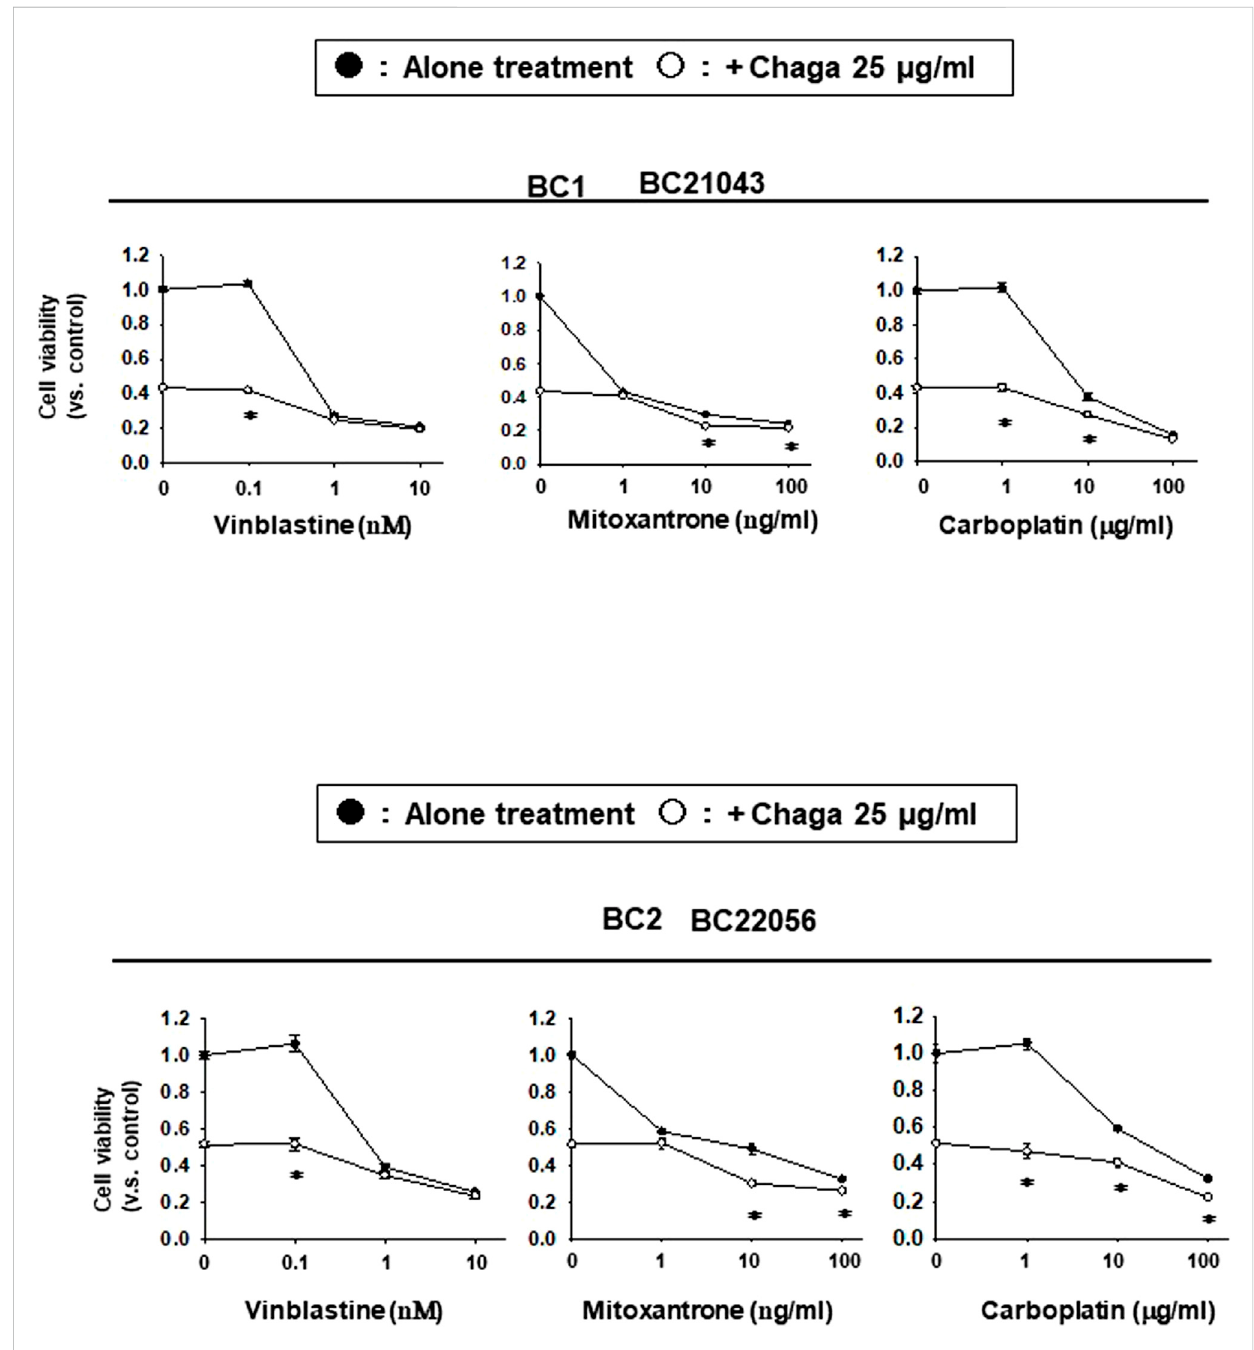
FIGURE 7 Potentiating effectsofChagaon thesensitivityof DBCOto anti-cancerdrugs. Using twostrainsof DBCO (BC21043 andBC22056),thepotentiating effects of Chaga on vinblastine (0.1 – 10 nM), mitoxantrone (1 – 100 ng/ml), or carboplatin (1 – 100 μ g/ml) were veri fi ed. Cell viability was determined using the PrestoBlue kit, and the value 1 on Y-axis represents the cell viability of each control. The effect of Chaga alone (25 μ g/ml) is shown on the Y-axis (opened circle between the values 0.4 and 0.6). The effect of cytostatic alone is shown in line with black circles and the effect of the combination is shown in line with white circles. Results were expressed as mean ± S.E.M (n = 3). * p < 0.05 vs. alone